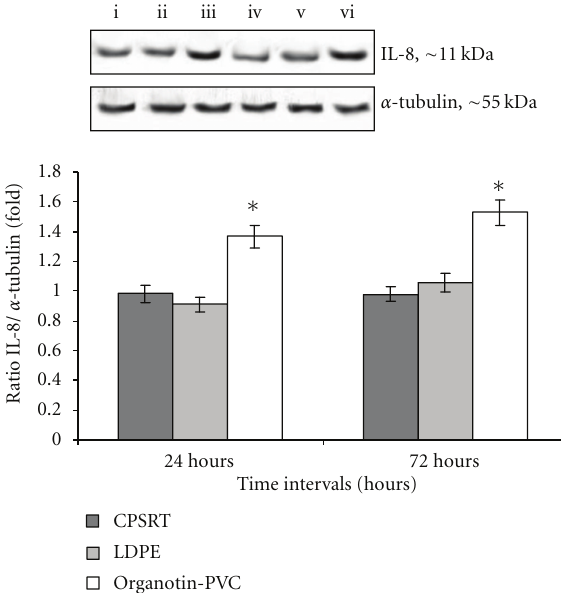
Figure 3: Western blot analysis of IL-8 in pHEK cultures. pHEK cultures were treated for 24 hours ((i) CPSRT, (ii) LDPE, and (iii) organotin-PVC) and 72 hours ((iv) CPSRT, (v) LDPE, and (vi) organotin-PVC) ( n = 3). ∗ For P ≤ 0 . 05 compared with both CPSRT and LDPE.